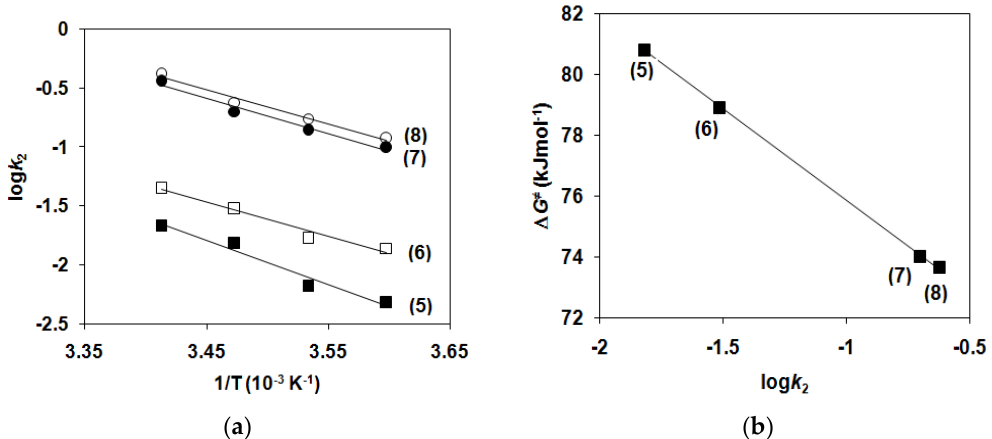
Figure 7. ( a ) Arrhenius plots of log k 2 versus 1/T for the Fe III2 ( μ -O)( μ -1,2-O 2 )(L 1–4 ) 2 (Solv) 2 ] 2+ ( 5 – 8 )-mediated disproportionation of H 2 O 2 in CH 3 CN. [ 5 – 8 ] 0 = 2 mM, [H 2 O 2 ] 0 = 24 mM. ( b ) Plot of Δ G ≠ versus lg k 2 for the reaction of